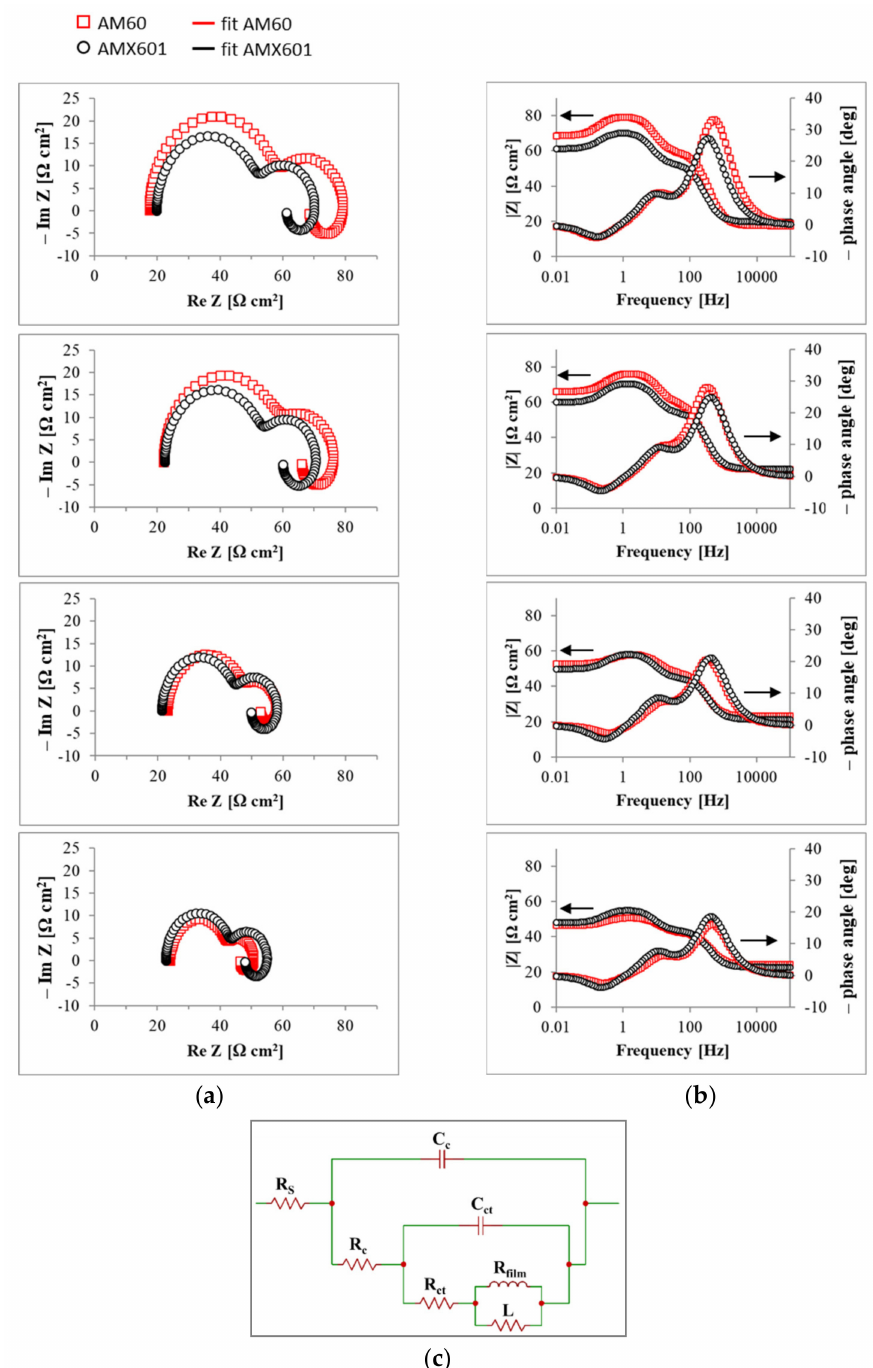
Figure 11. EIS results of AM60 and AMX601 alloys after different immersion periods in 3.5 wt% NaCl solution saturated with Mg (OH) 2 : ( a ) Nyquist plots; ( b ) Bode plots; ( c ) an equivalent circuit. Different results were obtained after immersion in NaOH solution, Figure 12. Two capacitance loops are observed after one hour of immersion. However, at longer immersion periods the Nyquist plots present only one capacitance loop with a significantly larger diameter, Figure 12a. In this case, the diameter of the capacitance loop is related to the corrosion resistance; and it is clearly seen that the diameter of the AMX601 alloy’s loop is bigger than that of AM60 alloy. Furthermore, no inductance loop is seen, even after 1 h of immersion, indicating strong protective film [61]. The Bode plots, Figure 12b, correlate with the Nyquist plots, indicating a better corrosion resistance for the AMX601